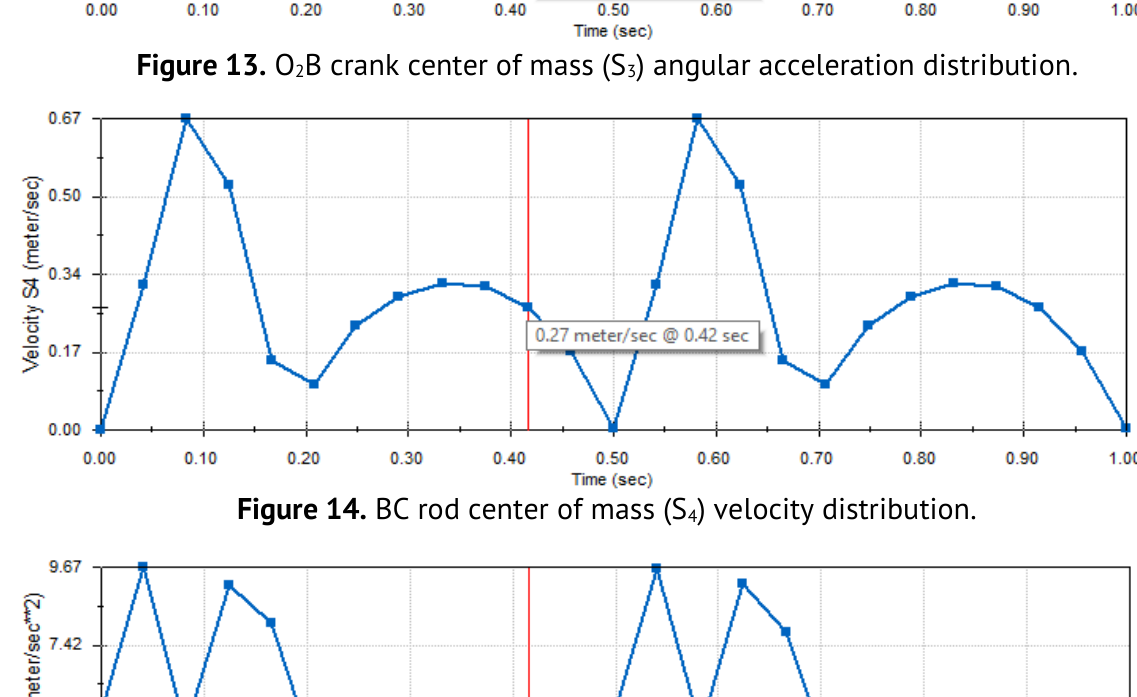
) angular acceleration distribution. 3